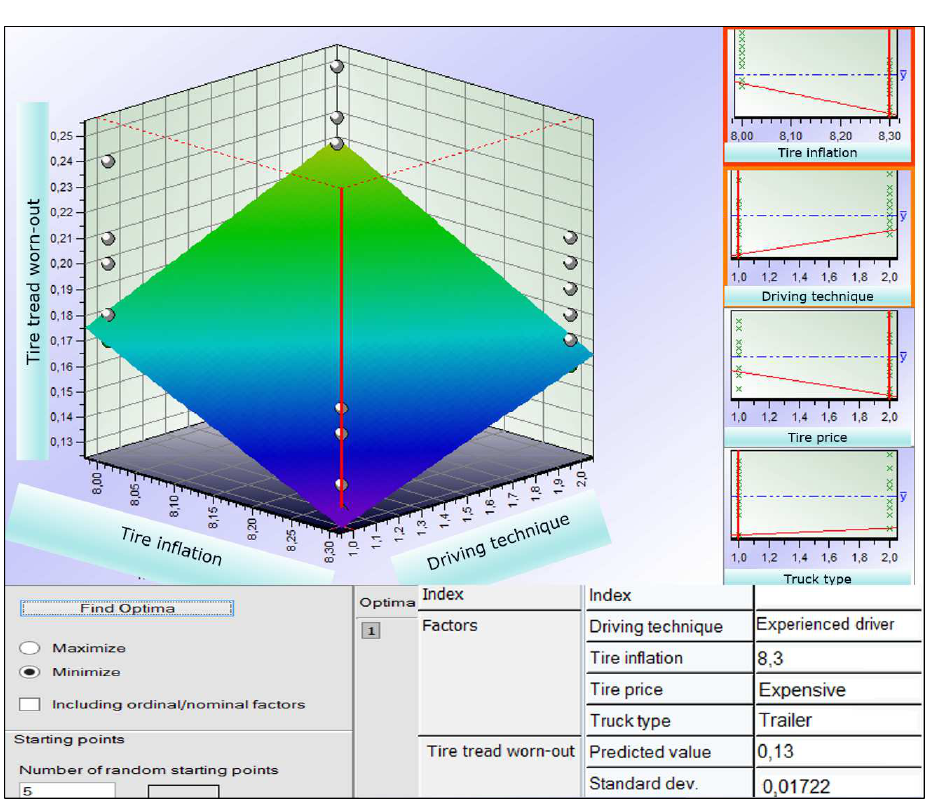
Figure 5 – Overview of optimal